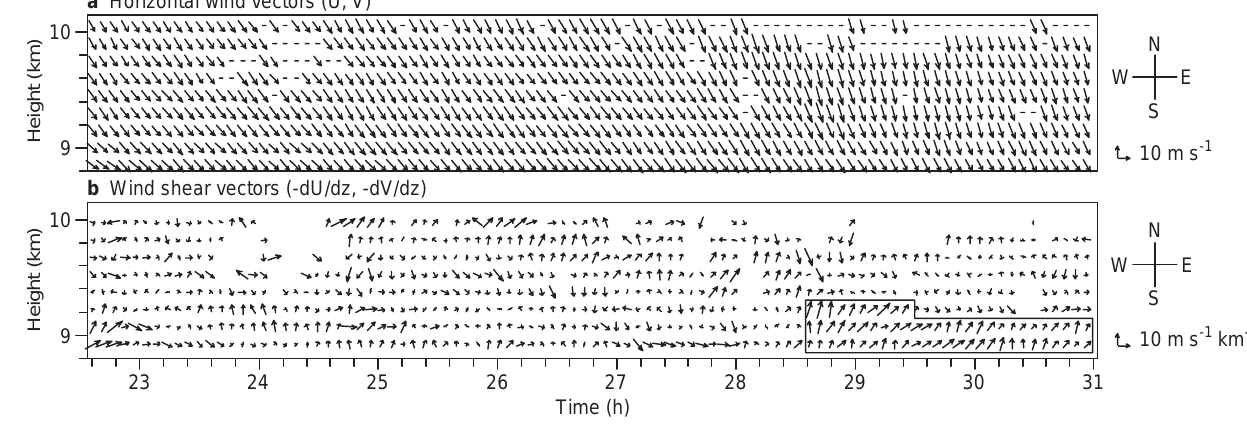
Fig. 3. Four typical maps of VHF echo power distribution patterns, averaged over 1-h time intervals, a and b are during atmospheric conditions of combined aspect sensitivity and windshear, c and d during conditions of aspect sensitivity but weak windshear. Dots mark the centres of the radar beam pointing directions (Fig. 1a). The echo power patterns in conditions of windshear ( plots a , b ) are